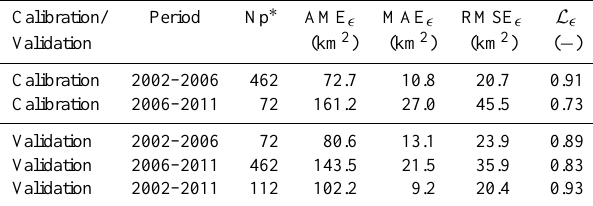
Table 7. Evaluation metrics of the water balance model, for the cali- bration and validation periods and for 2002–2011. Error (cid:15) is defined in Eqs. (14) or (15).